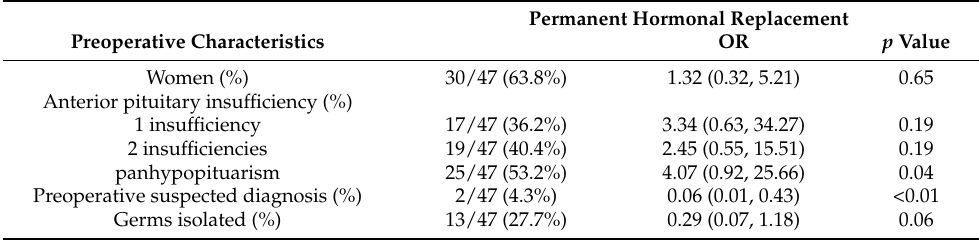
Table 3. Univariate analysis of risk factor determining hormonal